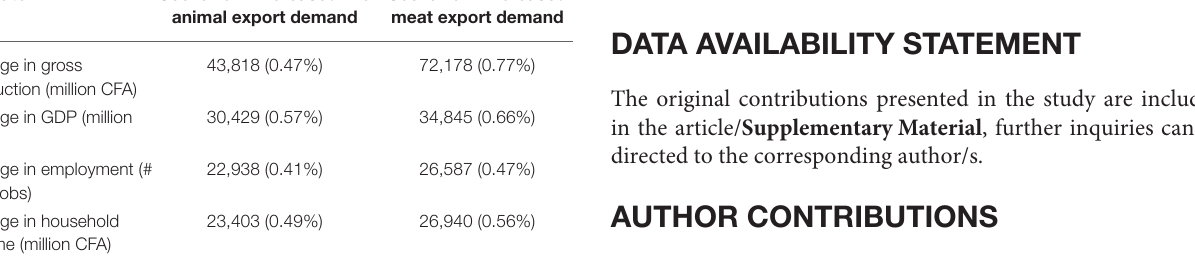
TABLE 6 | Scenario analysis of live animal vs. meat exports of output, GDP, employment, and household income.